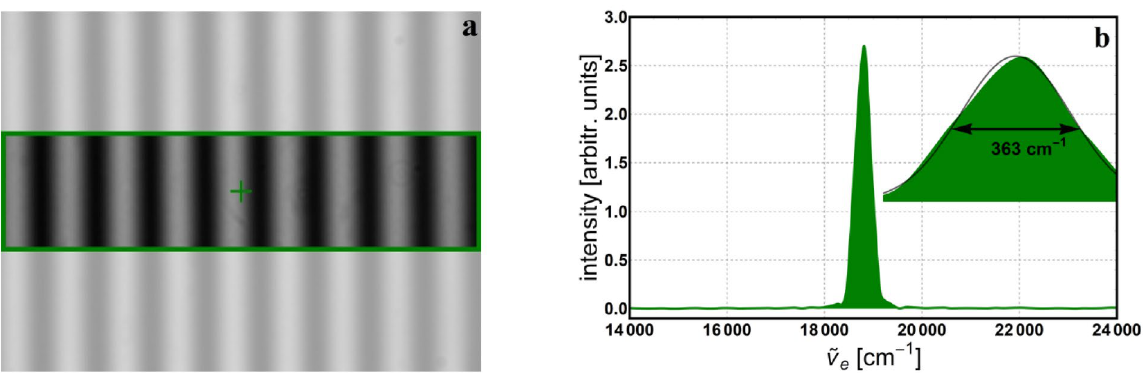
Figure 8. White LED light through a green filter with central wavelength of 532 nm: ( a ) interferogram with selected area and position of the pixel used for processing; ( b ) reconstructed monochromatic spectrum for 512 data points and its Gaussian fit.